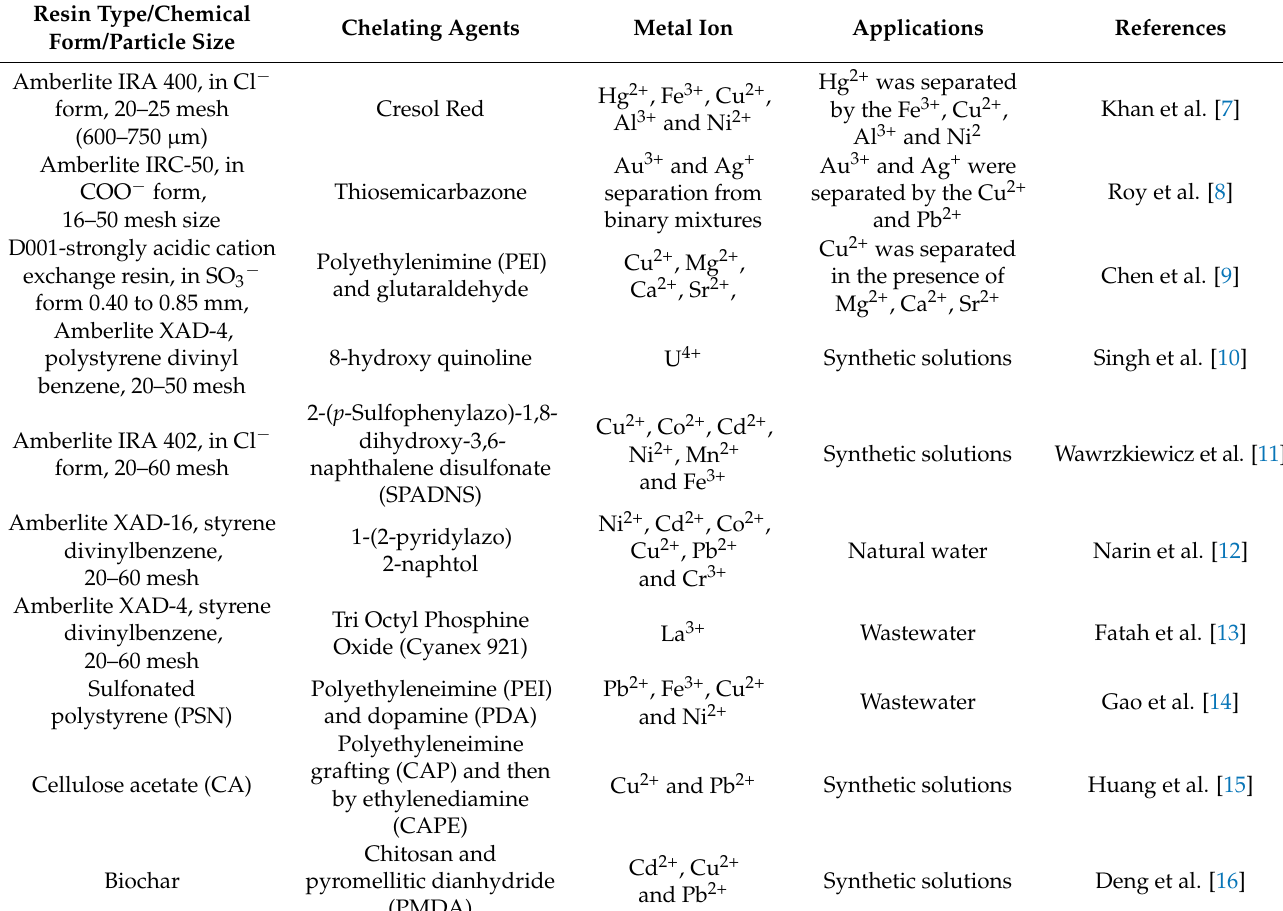
Table 1. Applications of chelating resin for metal ions